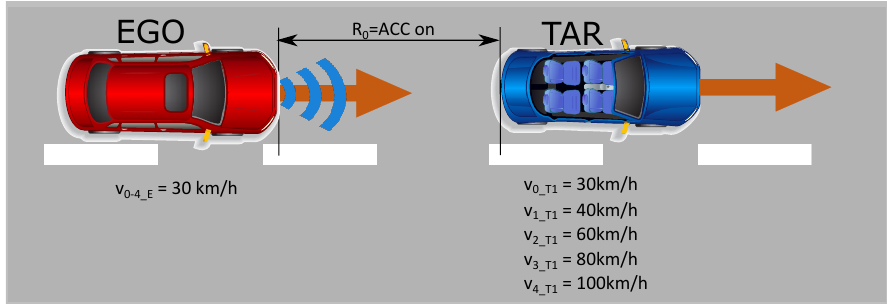
Figure 2. Target leaving with constant delta